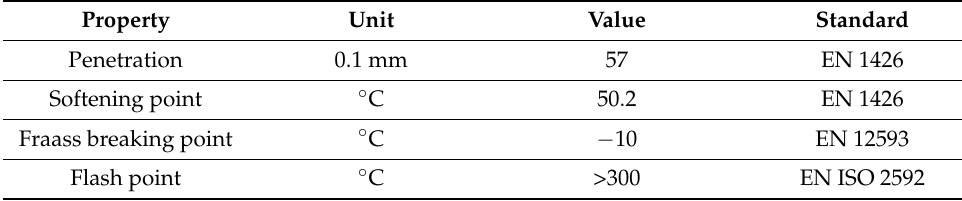
Table 2. Some of the physical properties of the used asphalt